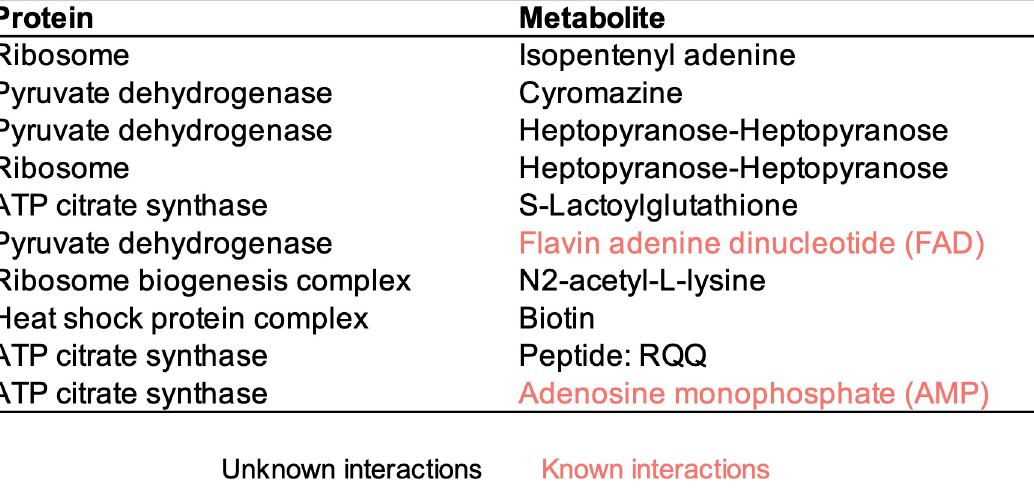
Fig 4. The top 10 scoring protein–metabolite interactions. Known interactions are shown in red, and proposed novel interactions are shown in black. One of the identified compounds, namely cyromazine, is an insecticide. It is not clear whether this compound has been introduced as part of the growth medium, or if this is a mis-annotation of an endogenous compound.